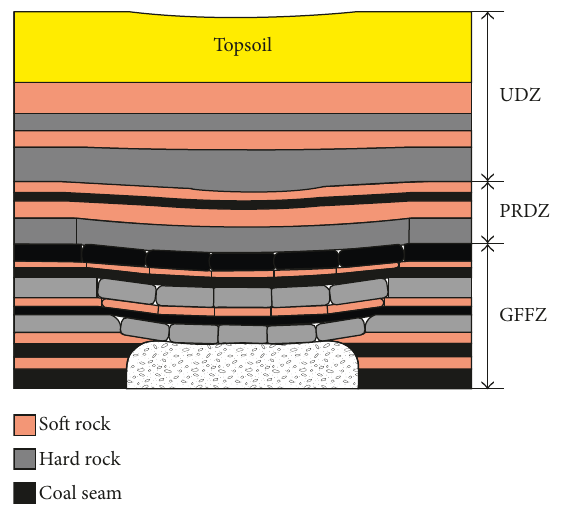
Figure 1: The overlying three zones for pressure relief, movement, and extraction of methane in mining of a coal seam